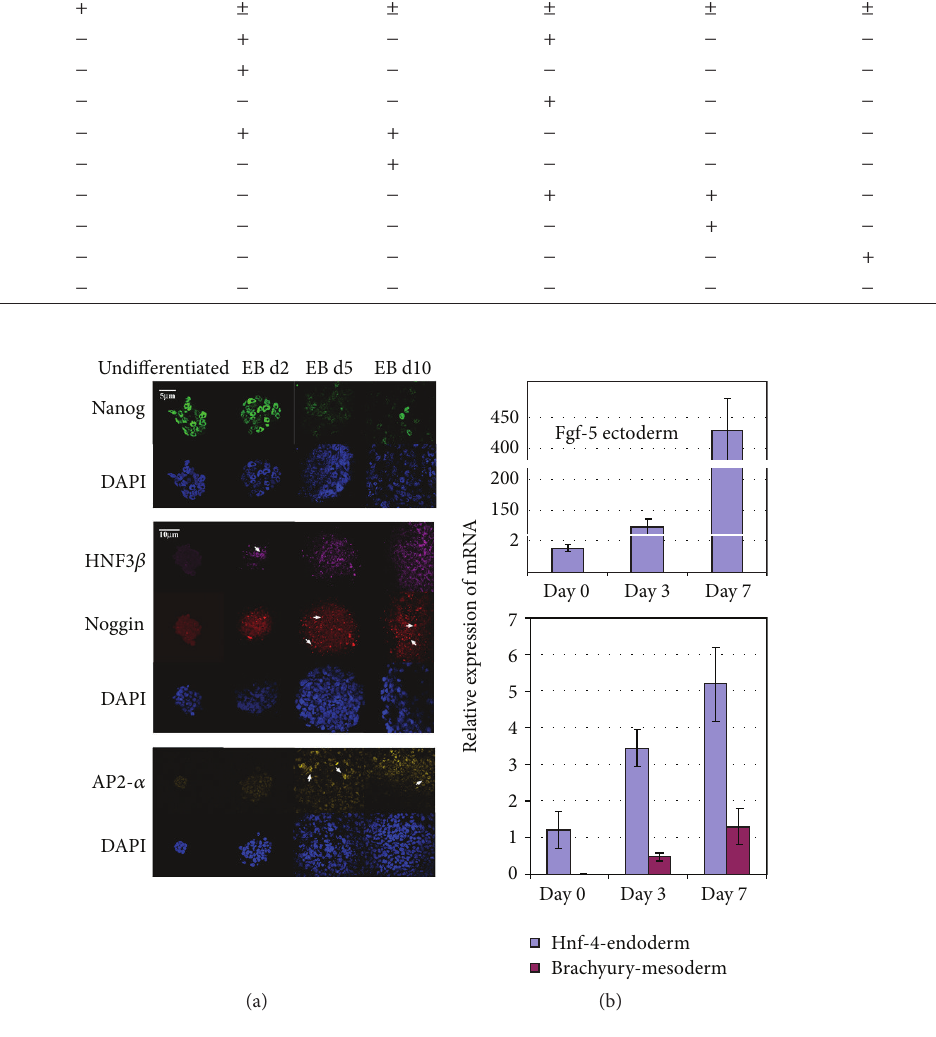
Figure 3: The data needed for Bayesian network equations can be easily acquired. Here, confocal analysis and qRT-PCR are examples of data acquisition that can be used to generate plots such as those found in Figures 4 and 6. (a) Immunofluorescence shows expression of Nanog in the nuclei of undifferentiated cells. This expression decreases drastically after 2 days of differentiation. HNF3 𝛽 expression is first visible at d2 in suspension. White arrowhead points to nuclear localization of this transcription factor. By d10, expression is localized to the right half of the EB. Noggin expression is first seen at day 5 and, as expected of a secreted factor, localizes to vesicles in the cytoplasm (white arrows). At day 10 Noggin is confined to the left half of the EB. Ap2- 𝛼 is first detected at d5 in suspension. Like the other markers, by d10 Ap2- 𝛼 shows specific staining in one portion of the EB. 5 𝜇 m scale applies to all images in upper panel. 10 𝜇 m scale bar applies to all images in lower panel. (b) qRT-PCR of EBs at specified days of differentiation illustrates one method for understanding timing of germ layer development using germ layer-specific markers Fgf5 for ectoderm, Hnf-4 for endoderm, and Brachyury for